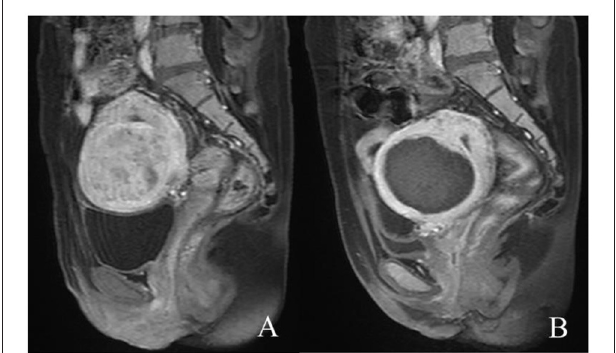
FIGURE 1 | Contrast-enhanced MR images before and after HIFU treatment. (A) The fibroid was submucous, anterior, and hyperintense before treatment; (B) the non-perfused volume was shown inside uterine fibroid after